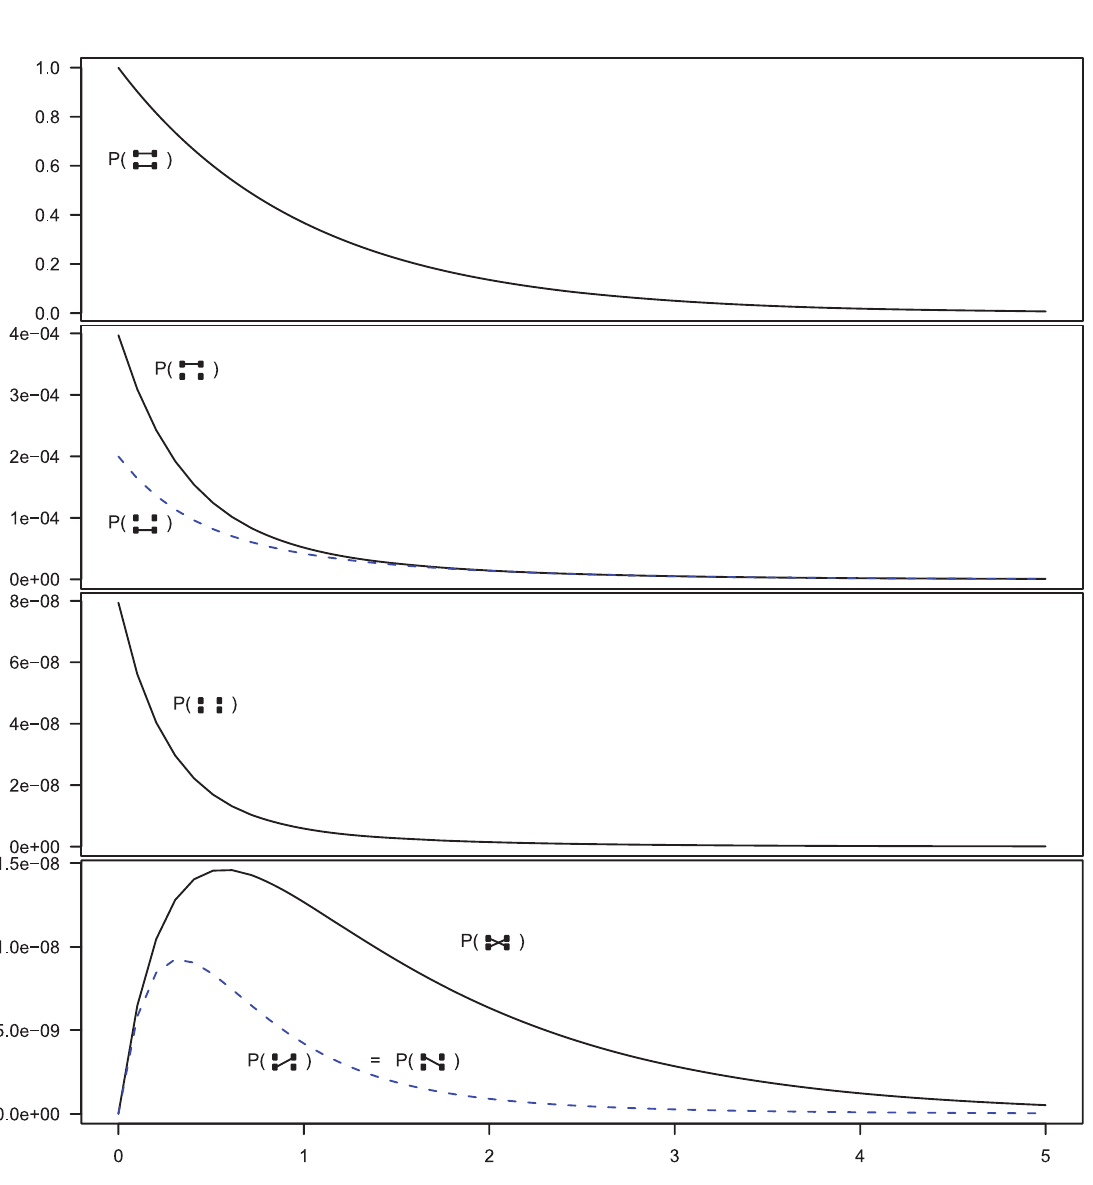
Figure 5. Evolution of V B states in the two-sequence CTMC. The figure shows the beginning states in the two-sequence CTMC and how their probabilities evolve over time. The asymmetry between which original sequence is linked versus unlinked, when only one sequence is linked (the second plot from the top) is caused by the differences in effective population size within the single-sequence CTMC system used for determining the initial distribution of the two-sequence distribution. The initial probability is taken from the two populations in Figure 3 at time 10 (the right edge of that figure) and the rates in the two-sequence system correspond to those for population 1 in Figure 3, i.e. a coalescence rate of 1 and a recombination rate of 2 : 10 { 4